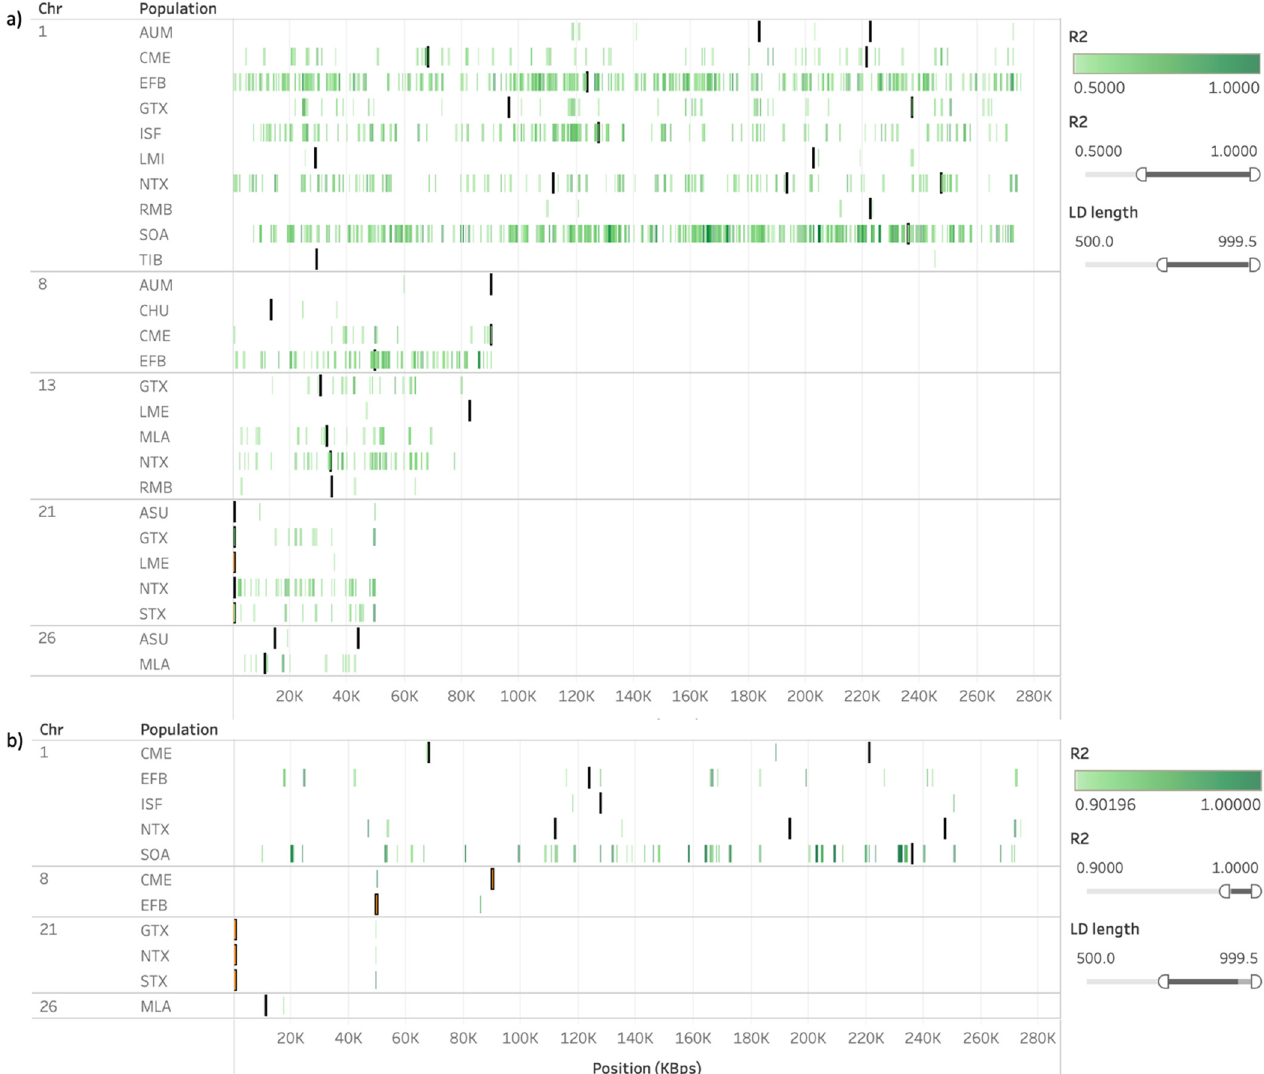
Figure 6. Heterozygosity-rich region (HRR) islands (orange) plotted against SNP pairwise calculation of r 2 (green) in chromosomes where common regions in HRR islands were detected for more than one sheep population. Regions in linkage disequilibrium (LD; measured as r 2 ) were restricted to SNP distances between 500 and 1000 kb, and r 2 > 0.5 ( a ) or r 2 > 0.9 ( b ). Only rows where both runs of homozygosity (ROH) islands were present and LD met the thresholds were presented, as a default and immutable requirement of Tableau’s visualization.